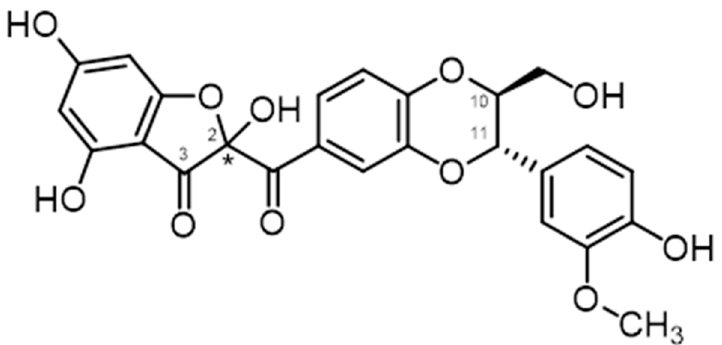
Figure 10. Structure of silybin B metabolite 2,4,6-trihydroxy-2-(3-(4-hydroxy-3-methoxyphenyl)-2- (hydroxymethyl)-2,3-dihydrobenzo[1,4]dioxine-6-carbonyl)benzofuran-3-(2 H )-one